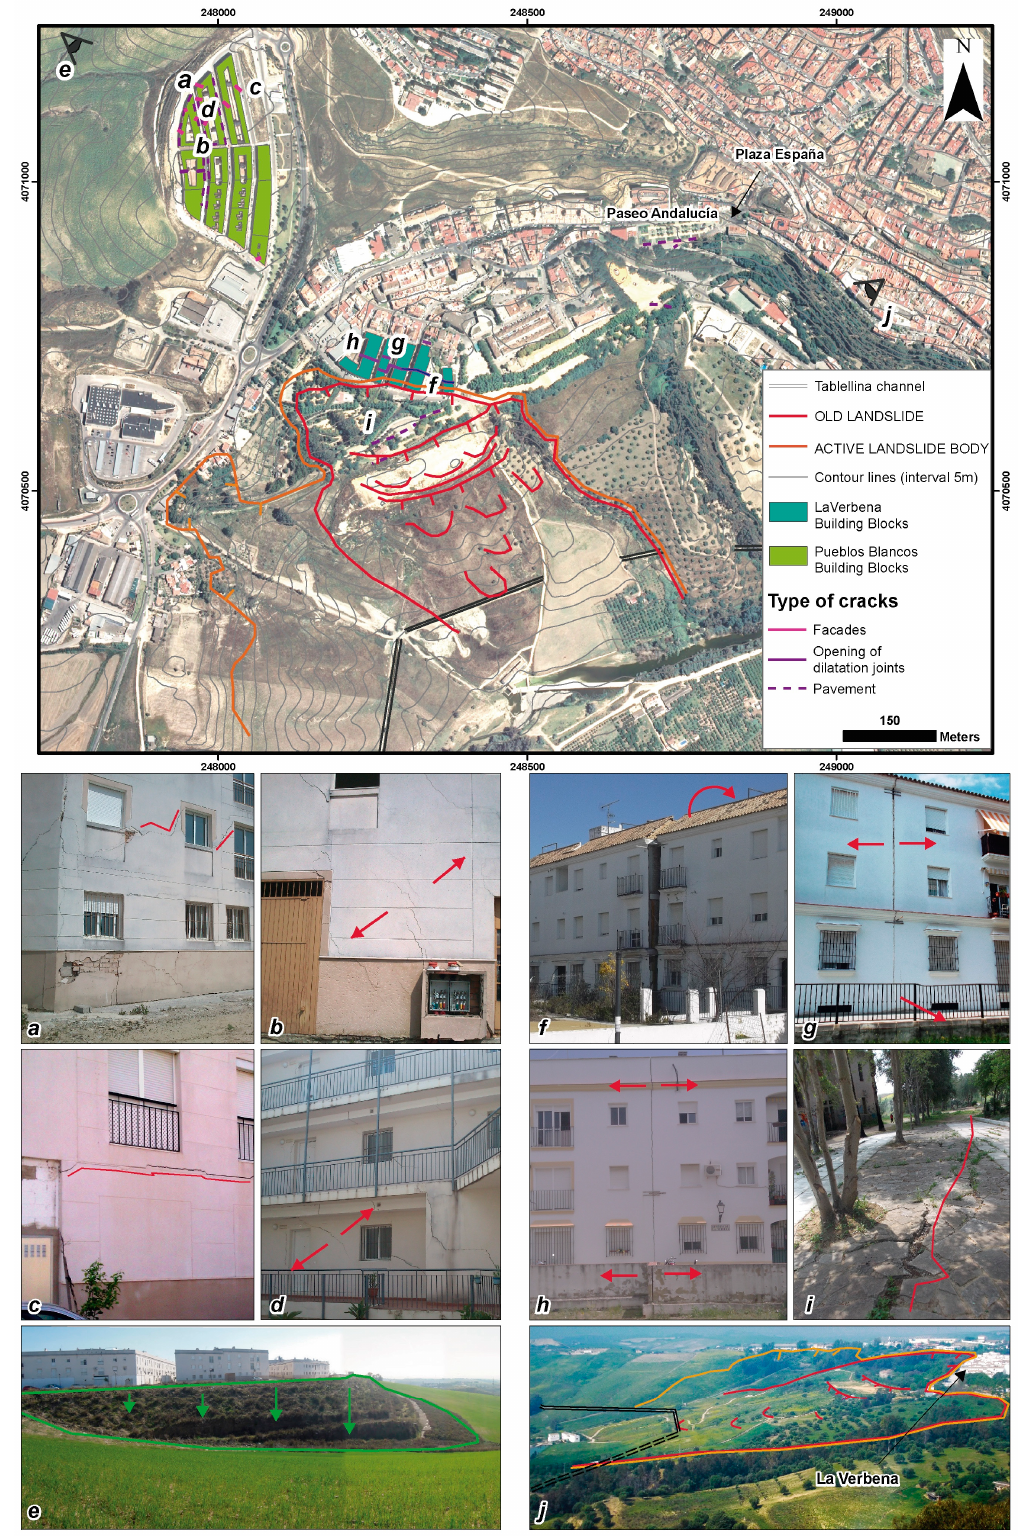
Figure 5. Inventoried cracks layout of La Verbena and Pueblos Blancos neighborhoods along with main landslide features. ( a – e ) Pueblos Blancos: 45° angle dip and horizontal cracks in facades and in the internal patios and general view of the earth fill undergoing differential compaction. ( f – j ) La Verbena: building tilting, opening of the dilatation joints, pavement disrepair caused by numerous cracks at the head of the scarp (old train station location) and general view of the Arcos de la Frontera landslide.